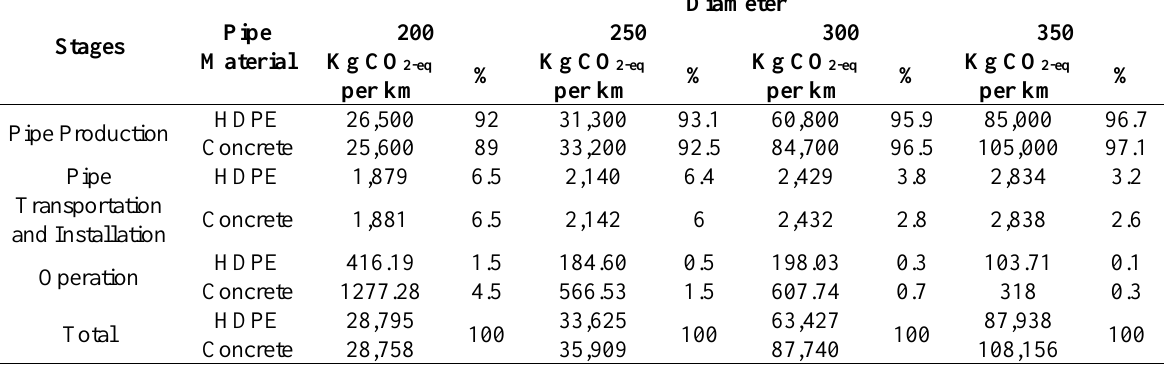
Table 3. GHG emission through different stages of HDPE and Concrete pipes life